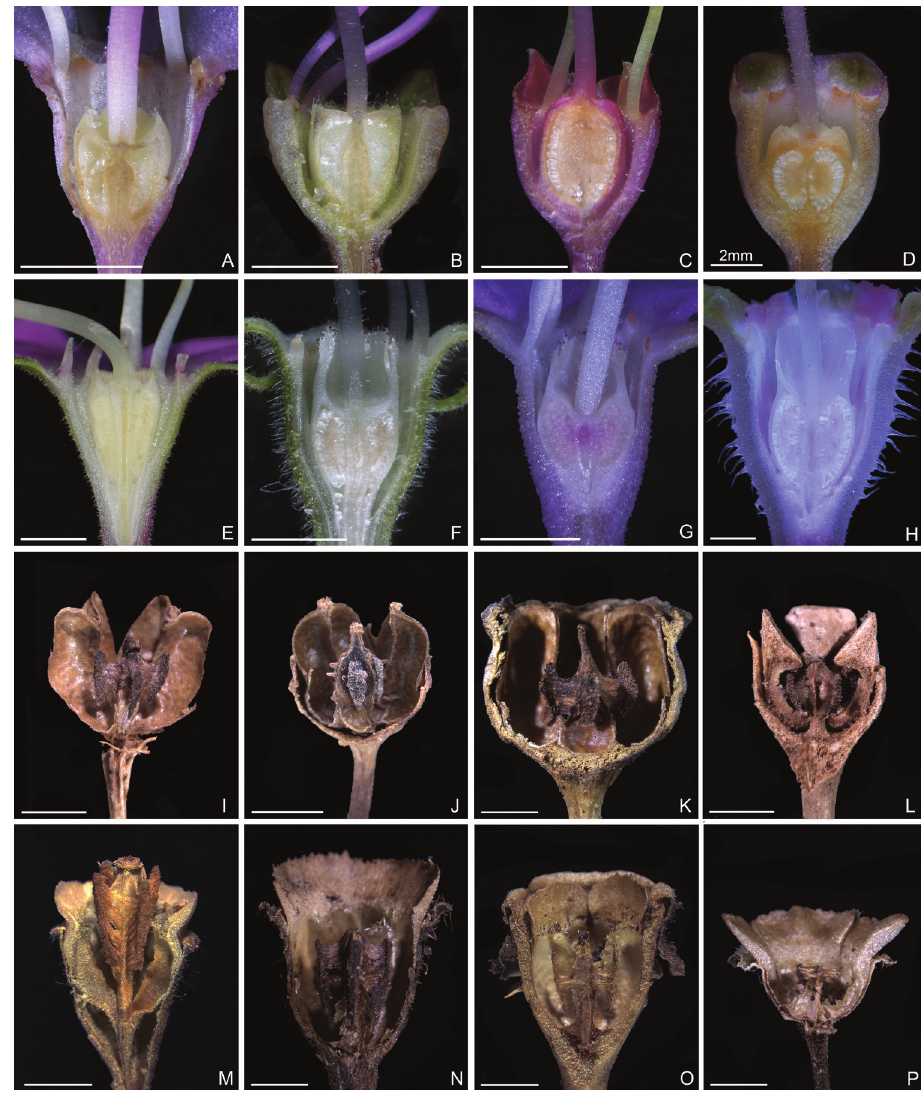
Figure 8. Longitudinal section of ovary ( A–H ) and old fruit ( I–P ). A–D Tashiroea clade, crowned or uncrowned ovaries at anthesis: A T. amoena ( Y. Liu 571 ) B T. quadrangularis ( Y. Liu 585 ) C T. biglandu- laris ( Y. Liu 553 ) D T. sinensis ( Y. Liu 569 ). E–H Bredia clade, crowned ovaries at anthesis: E B. hirsuta ( Y. Liu 563 ) F B. fordii var. micrantha ( Y. Liu 580 ) G B. plagiopetala ( Y. Liu 459 ) H B. longiradiosa var. pulchella ( Y. Liu 485 ). I–L Tashiroea clade, uncrowned, rarely crowned capsules: I T. amoena ( Y. Liu 571 ) J T. biglandularis ( Y. Liu 553 ) K T. sinensis ( Y. Liu 569 ) L T. oligotricha ( Y. Liu 468 ). M–P Bredia clade, crowned capsules: M B. dulanica ( Y. Liu 565 ) N B. fordii ( Y. Liu 444 ) O B. latisepala ( Y. Liu 557 ) P B. repens ( Y. Liu 558 ). Scale bars: 2